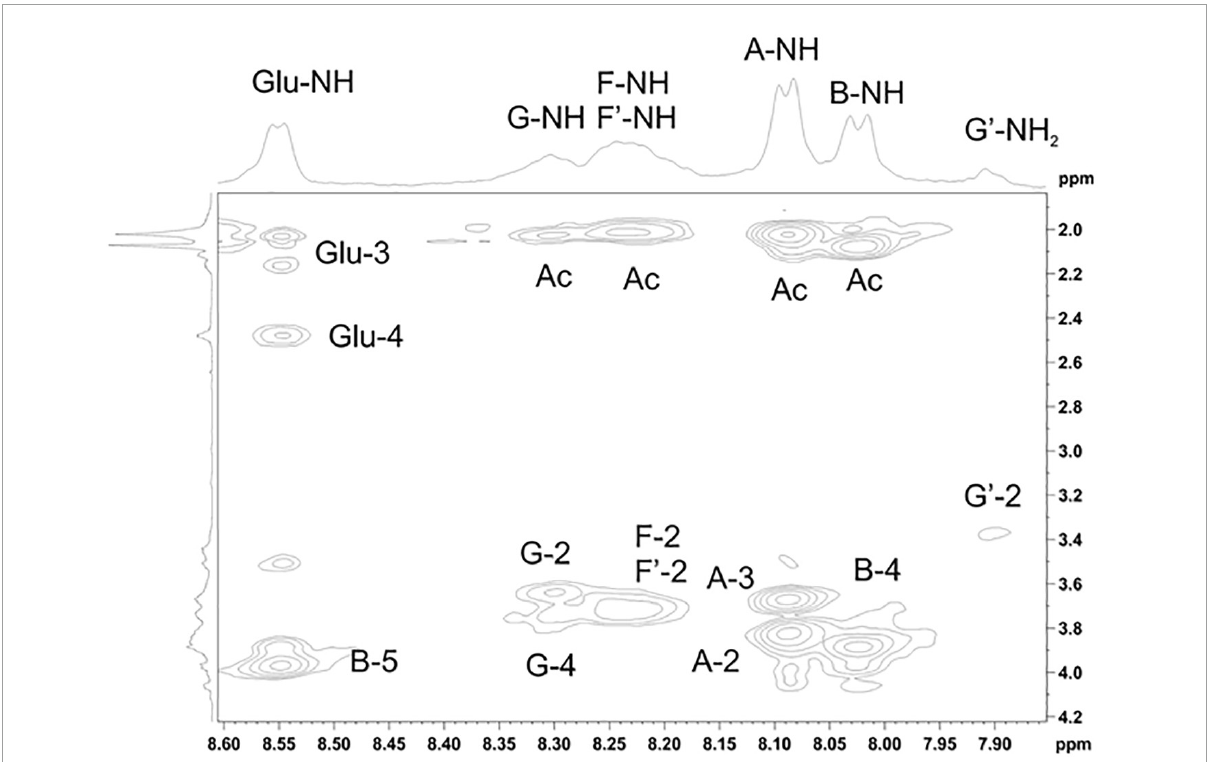
FIGURE5 Parts of the 2D ROESY spectrum of M. luteus C01 matrix polysaccharides [24 h (control)] eluted in 0.1 M phosphate buffer measured in a 9: 1 H 2 O/D 2 O mixture. The corresponding parts of the 1 H NMR spectra are shown along the horizontal and vertical axes, respectively. Numbers refer to the protons and carbons of sugar units designated by the letters shown in Table 5 .